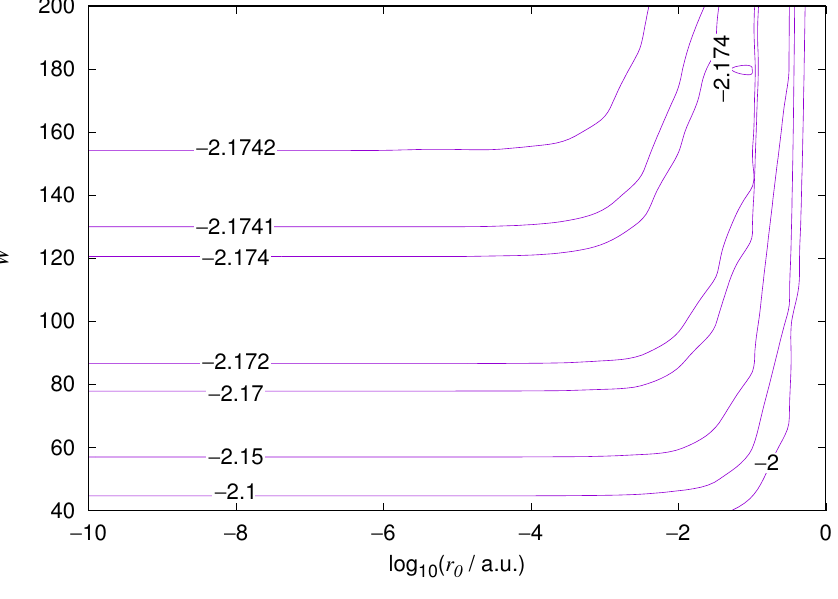
Figure 10. Helium 1s2s 3 S total energy. The HF limit is given in Table 1. Notations as in Figure 1. The most accurate computations are in the upper left corners of the figures. The orbitals of He 1s2s, except He 1s2s 3 S 1s, are not continuous at all at r 0 , and no continuity plots are presented for them. The computation results and exact results are given in Table 1. For the EPP–Galerkin method the best energies (largest basis and smallest r 0 ) of the computed systems are presented. The OIW–Galerkin results with same number of basis functions and grid spacing the same order of magnitude as for the most accurate EPP results are given, too. The accuracies of both of the methods depend on the grid spacing. The EPP–Galerkin method gives better results with the same number of basis functions and larger grid spacing. The results of the Finite Difference Method are also given. Note that for He 1s2s systems, the OIW–Galerkin method with a basis set of 601 functions and finest